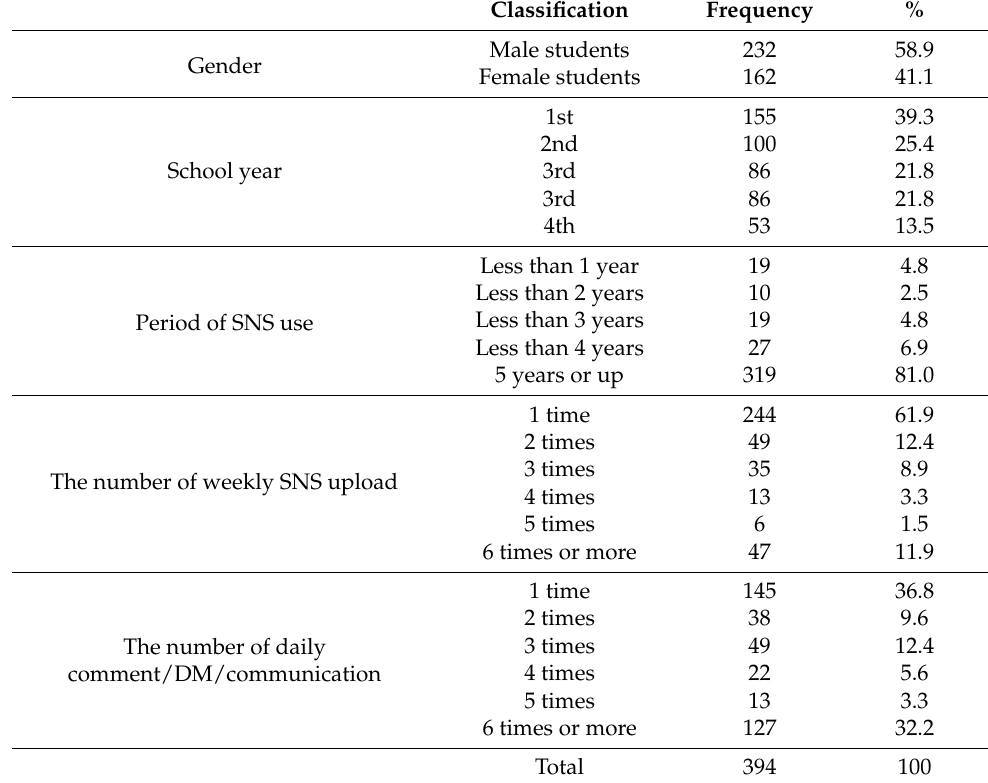
Table 1. General characteristics (N = 394).